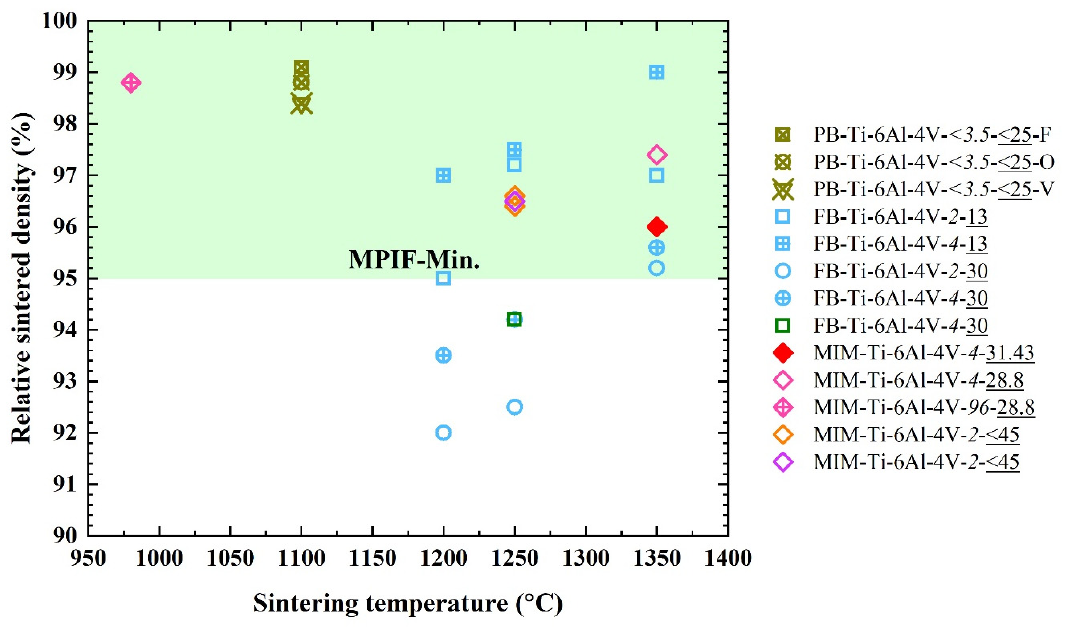
Figure 21. Sintering temperature vs. relative sintered density map of Ti-6Al-4V alloys fabricated by metal MEX process with different conditions comparing with MPIF standard 35 for MIM materials. The italic number represents sintering time (h) and the underlined number represents mean powder size (µm). Data from [78,79,109,163,164,170–172].